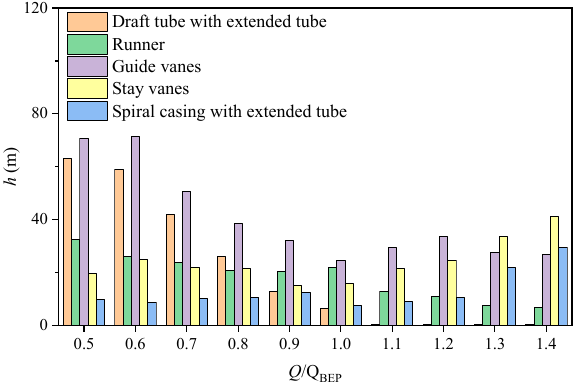
Figure 8. Changes of entropy production in each simulated domain.